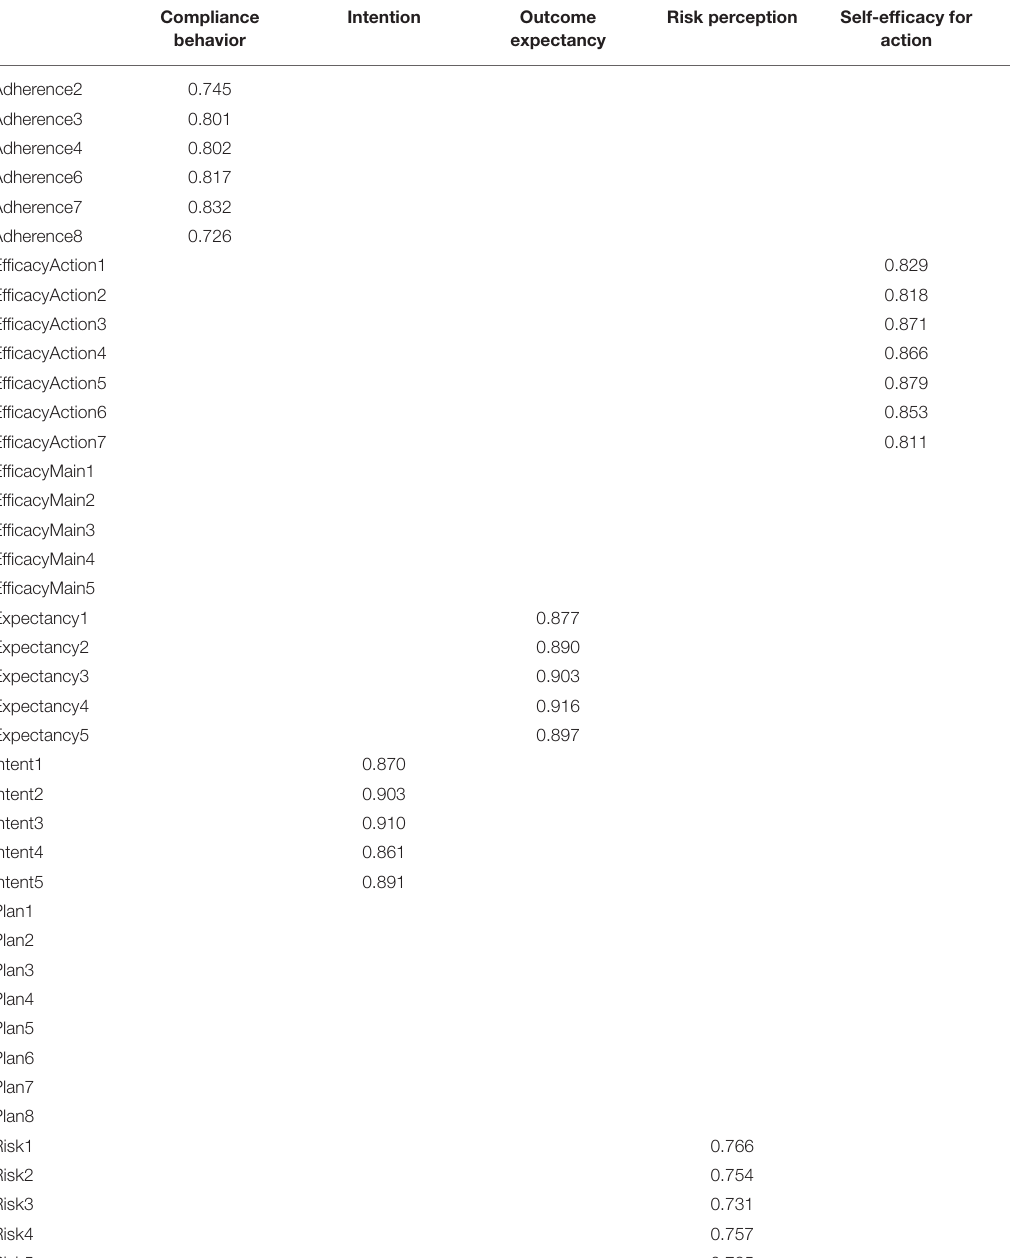
TABLE 4 | Indicator reliability/outer